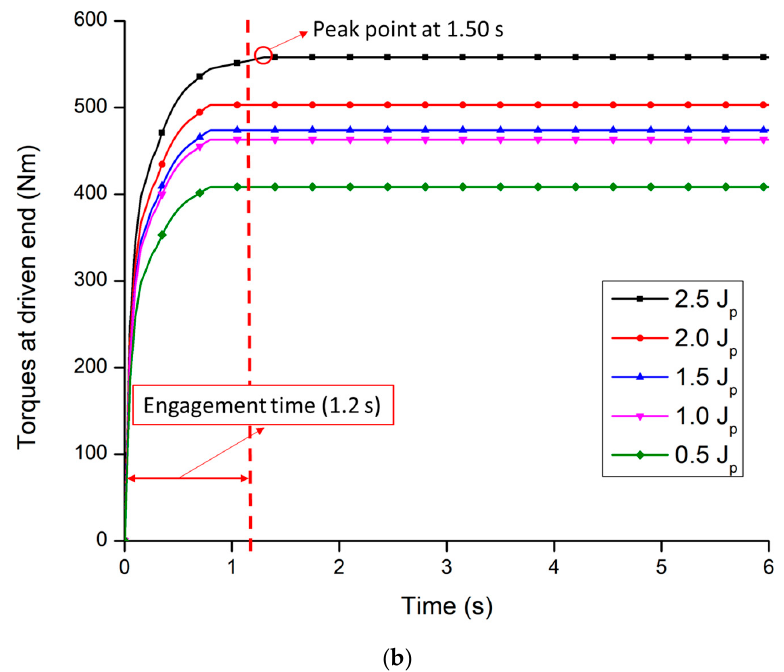
Figure 12. The torque of the clutch at a different moment of inertia: ( a ) Driving end; ( b ) Driven end. Table 5. The times of peak torques at a different moment of inertia.